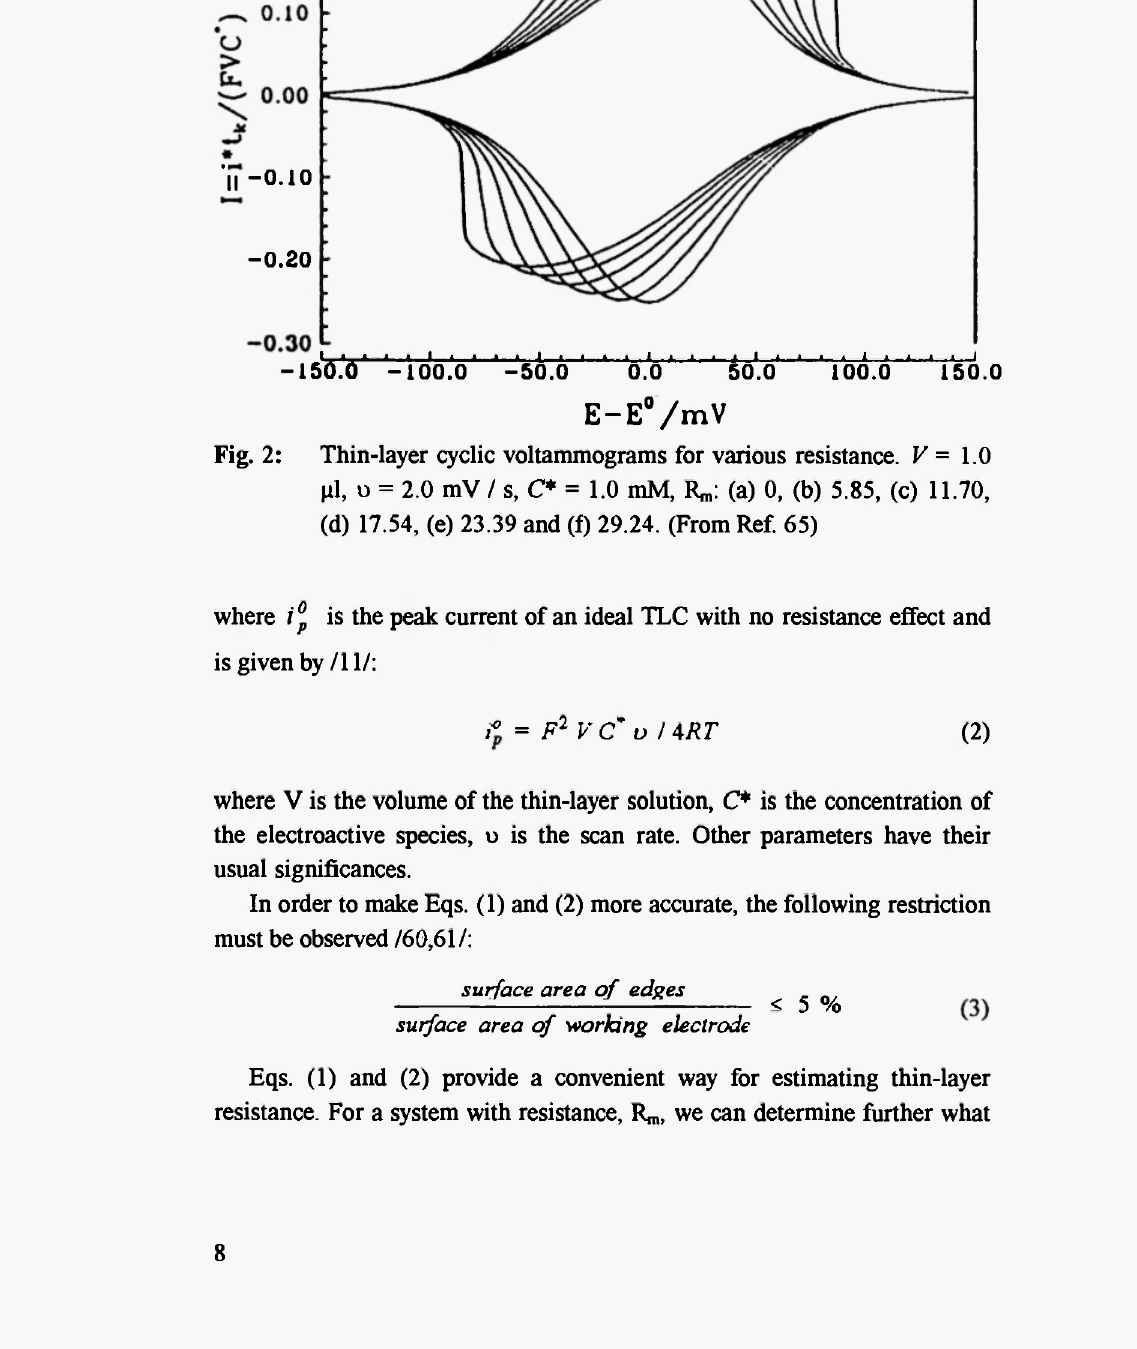
Fig. 2: Thin-layer cyclic voltammograms for various resistance. V =